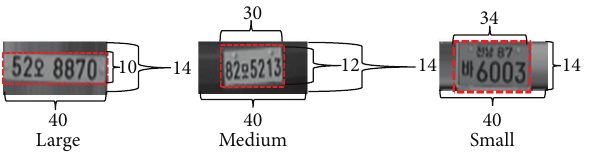
Figure 8: Examples of filtered images after using Gaussian filter: (a) positive samples and (b) negative samples.